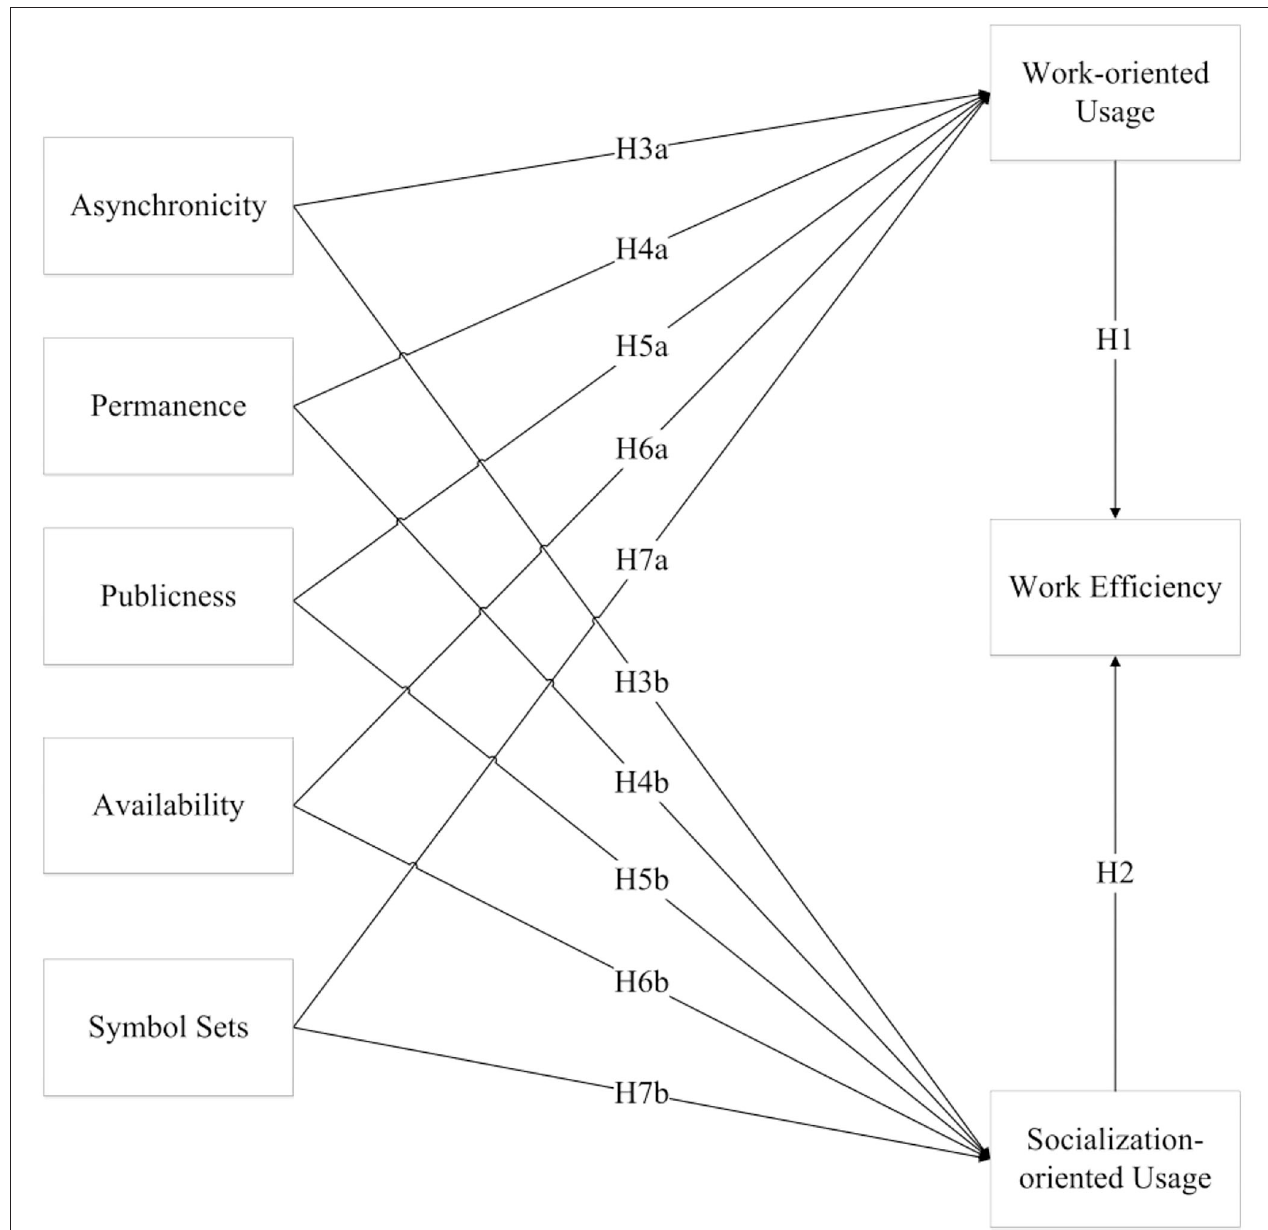
FIGURE 1 | Research model and